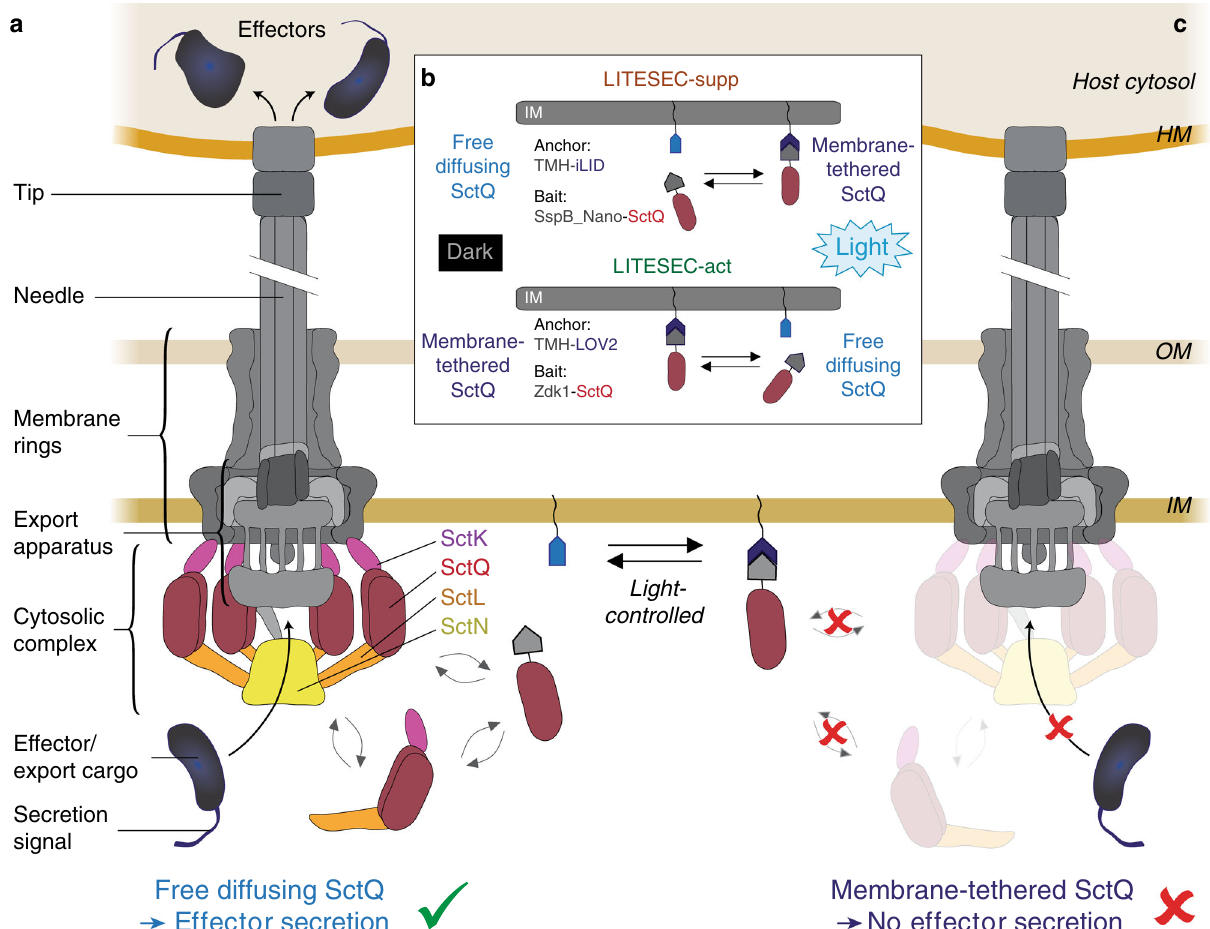
Fig. 1 Working principle of the LITESEC systems — light-controlled activation and deactivation of protein translocation by the type III secretion system. a Schematic representation of the active T3SS injectisome (modi fi ed from ref. 6 ). Left side, main substructures; right side, dynamic cytosolic T3SS components. Effector translocation by the T3SS is licensed by the functional interaction of the unbound bait-SctQ fusion with the T3SS. b Different states of the bait and anchor proteins in dark and light conditions. In the LITESEC-supp system (top), the bait protein, a fusion of the smaller interaction switch domain SspB_Nano and the essential T3SS component SctQ, is tethered to the inner membrane (IM) by a membrane anchor, a fusion of a transmembrane helix (TMH) and the larger interaction switch domain, iLID, in the light, and gets released in the dark. Conversely, in the LITESEC-act system (bottom), the bait protein, a fusion of the smaller interaction switch domain, Zdk1, and the essential T3SS component SctQ, is tethered to the membrane anchor, a TMH fusion of the larger interaction switch domain, LOV2, in the dark, and gets released by illumination. c Sequestration of the bait-SctQ fusion protein to the membrane prevents effector secretion. HM host membrane, OM bacterial outer membrane, IM bacterial inner